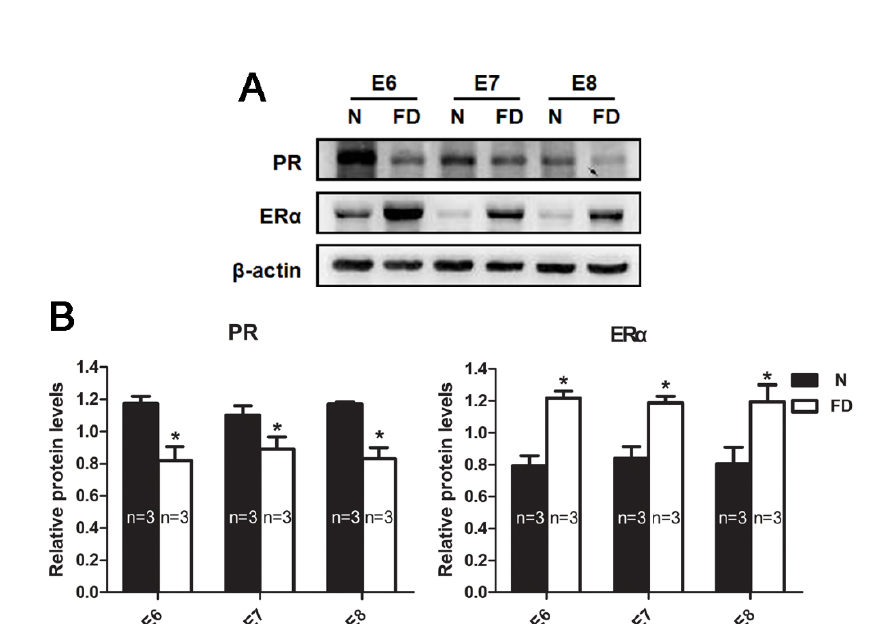
Figure 5. Western blot analysis of the expression of progesterone receptor (PR) and estrogen receptor α (ER α ) from Embryonic day 6 (E6) to Embryonic day 8 (E8). ( A ) Protein levels are expressed relative to the normal group and β -actin was used as a loading control. ( B ) Statistical analysis of protein expression from three independent experiments. (* p < 0.05).